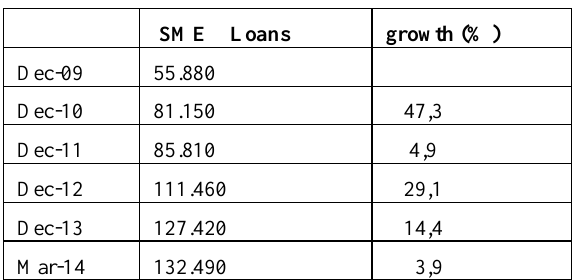
Table 4: The development of SME loans in Turkish Banking